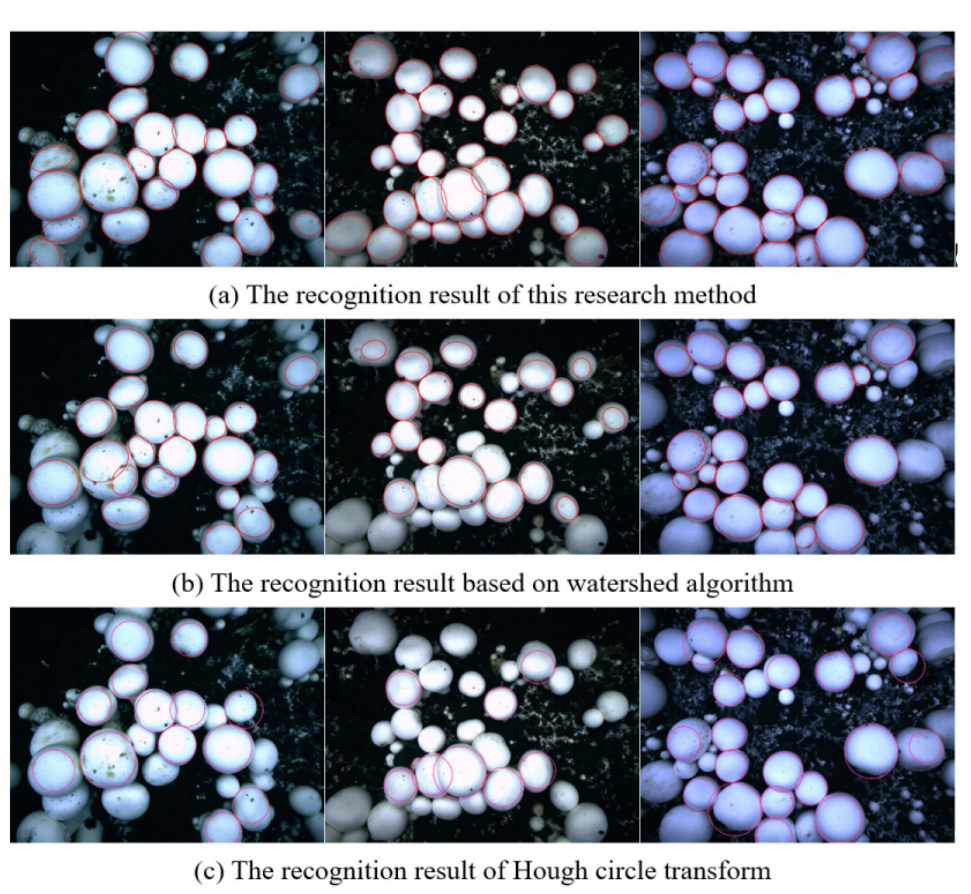
Figure 18. Comparison of the recognition effects of overlapping Agaricus bisporus.